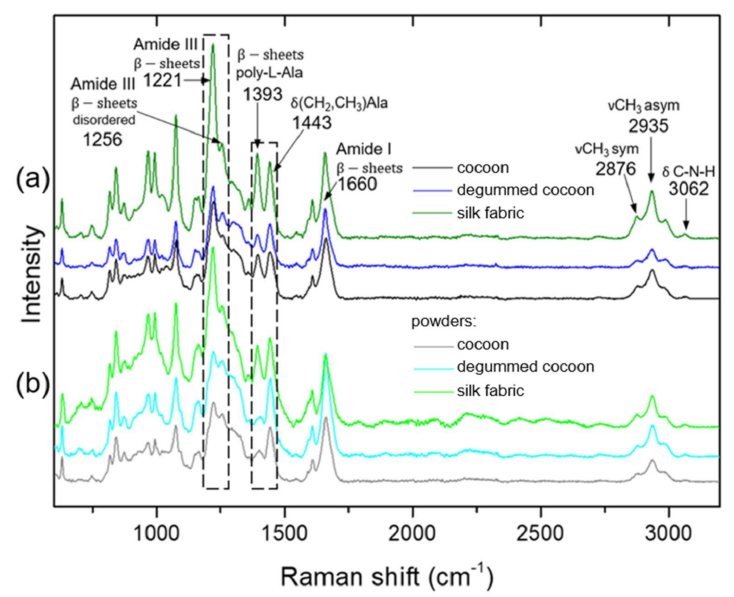
Figure 4. Raman spectra of ( a ) raw silk cocoons, degummed cocoons, and silk fabric; and ( b ) silk powders from raw cocoons, degummed cocoons, and silk